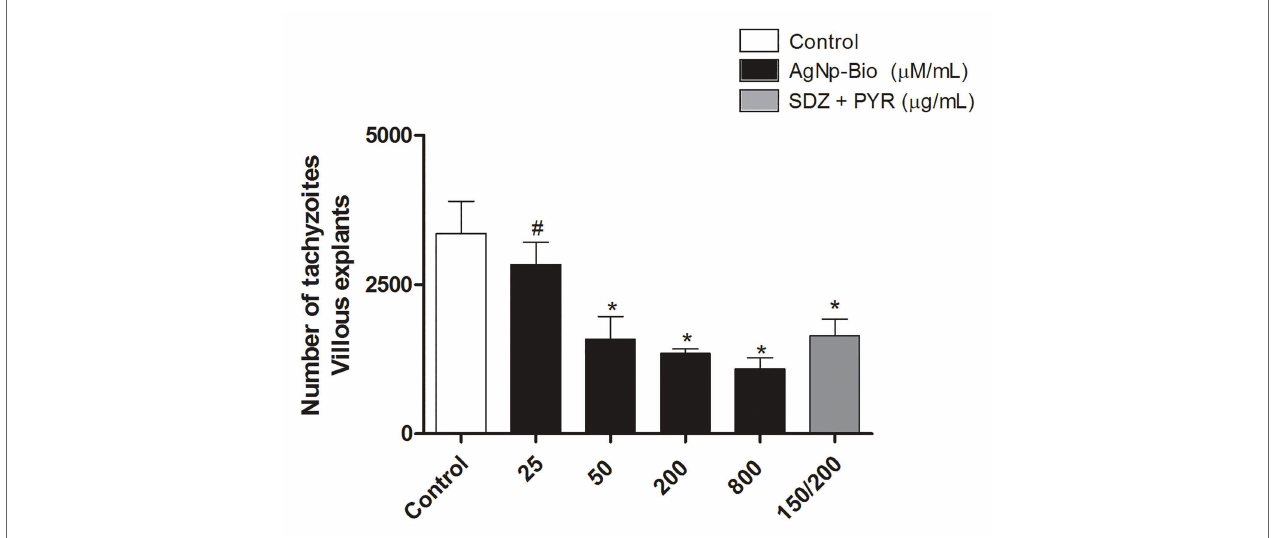
FIGURE 5 | Toxoplasma gondii proliferation (2F1 clone) in villi treated with different drugs. Villi were collected and cultured for 24 h, infected with T. gondii (RH-2F1 clone) for 24 h, and treated or untreated with nanoparticles in different concentration and sulfadiazine/ pyrimethamine (SDZ + PYR). Next, were treated for β -galactosidase colorimetric assay. Data were shown as mean ± SEM of T. gondii proliferation from three independents experiments in nine replicates. Significant differences in relation infected and untreated (control; * p < 0.05) and nanoparticles and SDZ + PYR ( ≠ p < 0.05). Differences between groups were analyzed by One- Way ANOVA with the Bonferroni multiple comparison post hoc